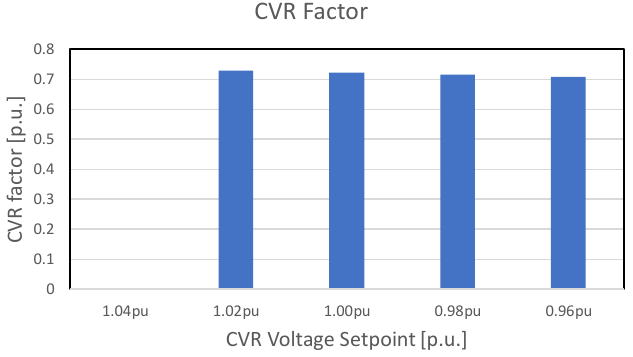
Figure 7. Total energy consumed in June for different CVR setpoints.